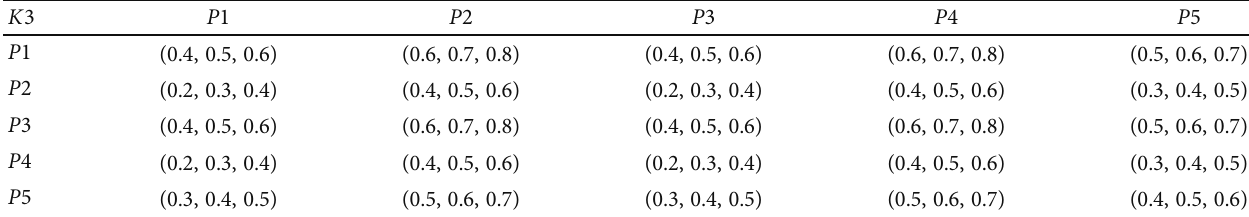
Table 8: Determination matrix of various indicators of mechanical equipment risk.